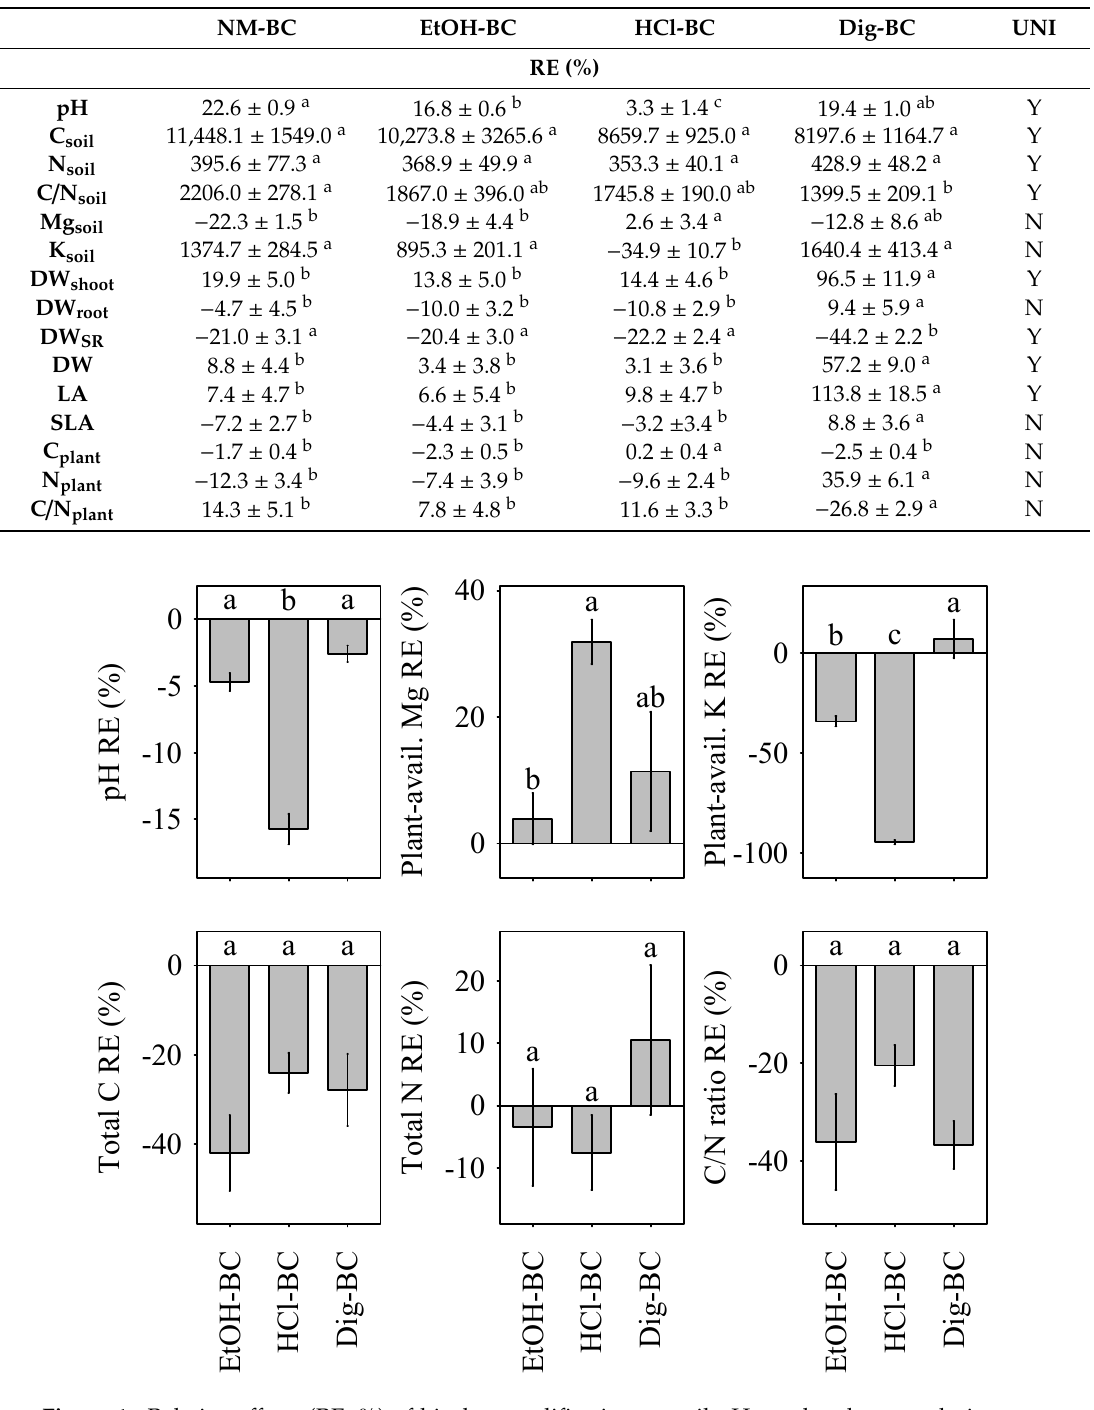
Figure 1. Relative effects (RE, %) of biochar modification on soil pH, total carbon, total nitrogen, plant-available magnesium, and plant-available potassium relative to the non-modified NM-BC. Different lower case letters indicate significant differences ( p < 0.05) between biochar modification effects, namely EtOH-BC, HCl-BC and Dig-BC. Data is shown as means with standard error ( n = 24).